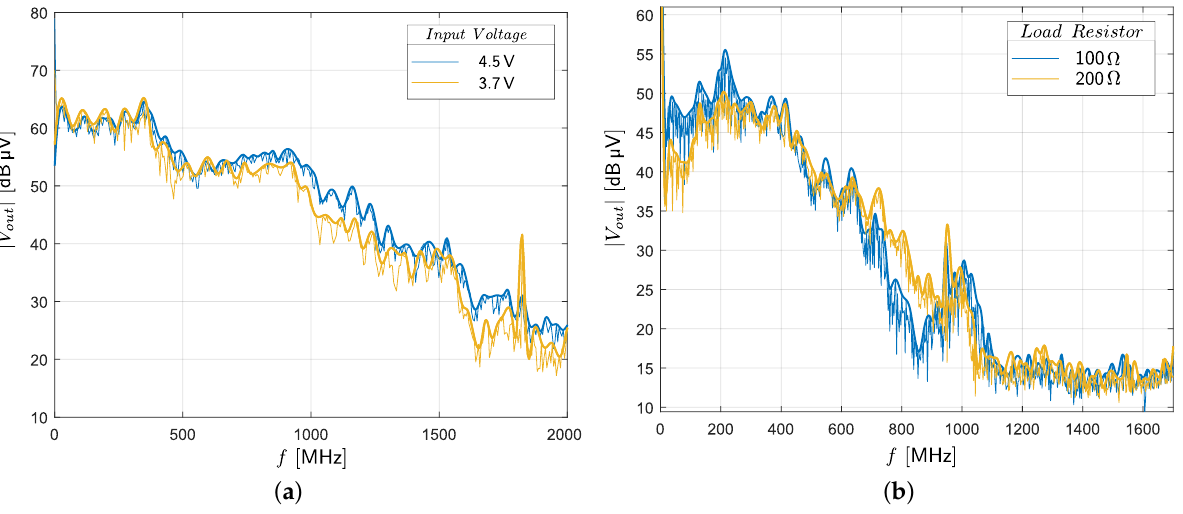
Figure 18. Influence of input voltage and load current on the noise spectrum of an inverting buck/boost converter. ( a ) ADP5075: frequency spectrum depending on input voltage; ( b ) TPS63700: frequency spectrum depending on load